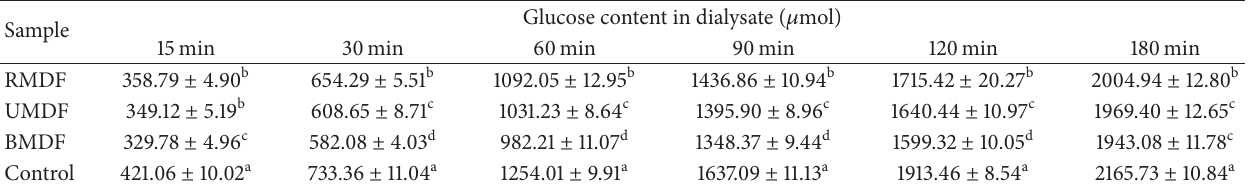
Table 2: Effect of different IDF fractions on glucose diffusion and 𝛼 -amylase activity.